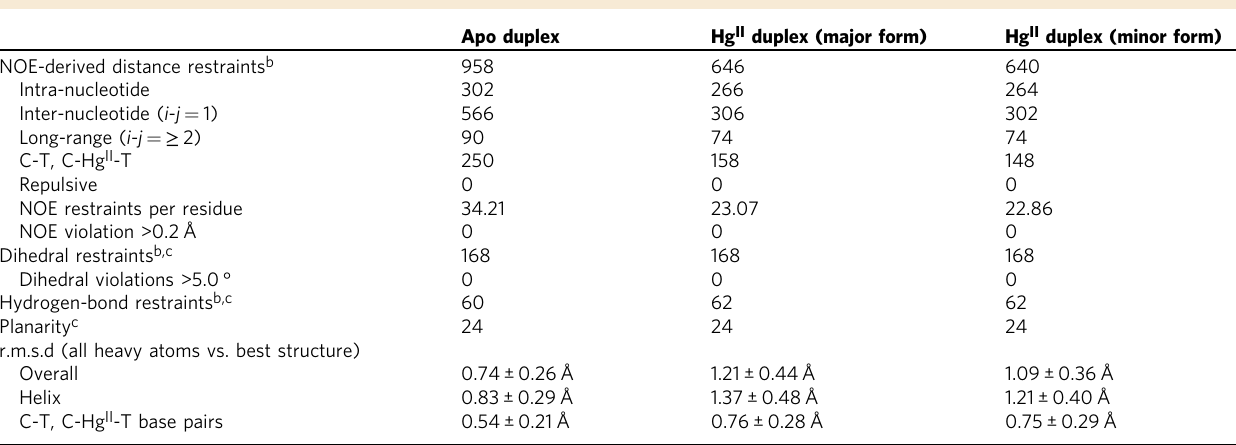
a Statistics are given for the 20 lowest energy structures from 200 calculated structures. b Experimentally derived constraints (Supplementary Figs. 14, 16). c Introduced constraints. The two additional hydrogen-bond restraints in the Hg II -containing duplexes re fl ect N3-N3/N4 restraints for metal binding. The r.m.s.d. values are given as mean±standard deviation. Source data are provided as a Source Data fi